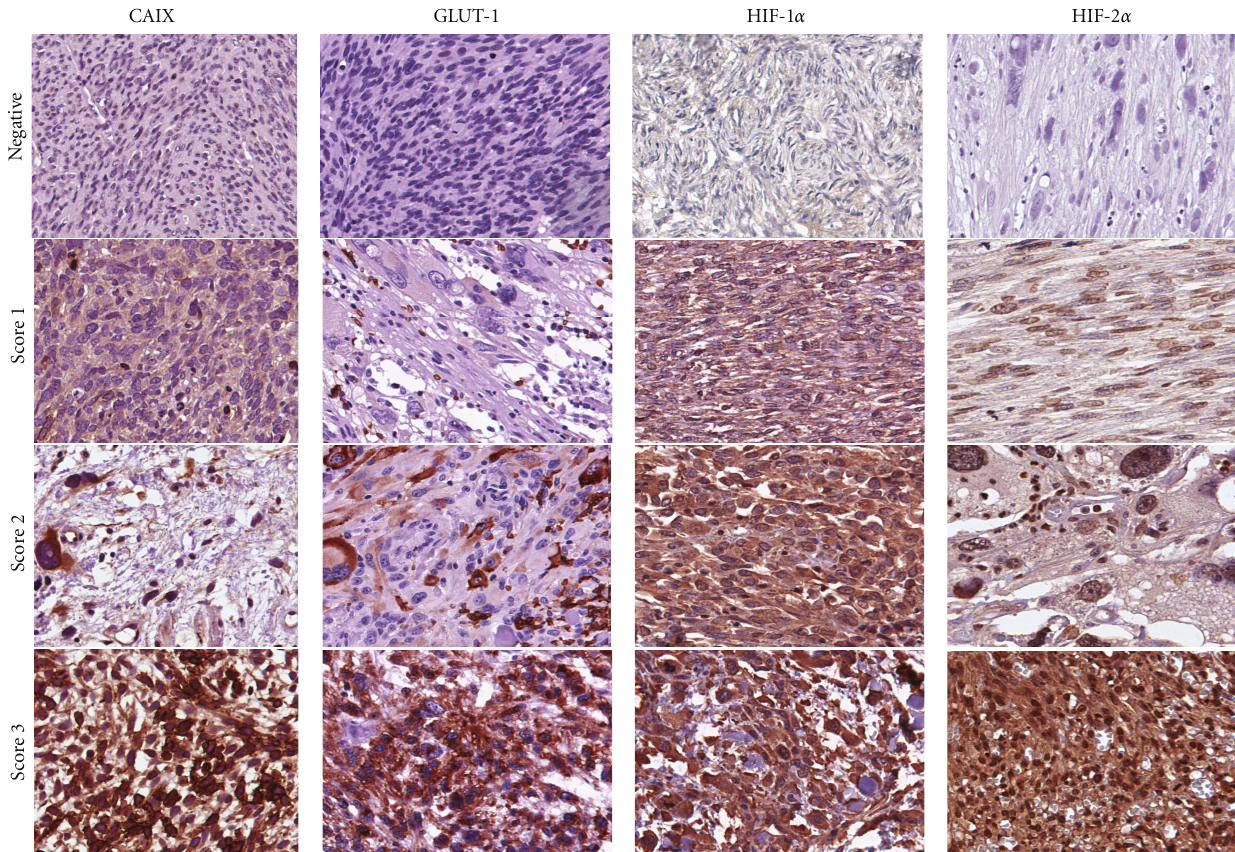
Figure 1: Immunohistochemical analysis in non-GIST STS representing negative, and score 1–3 of CAIX, GLUT-1, HIF-1 α , and HIF-2 α . non-GIST STS: non-gastrointestinal stromal tumor soft-tissue sarcomas, CAIX: carbonic anhydrase IX, GLUT-1: glucose transporter-1, and HIF-1/2 α : hypoxia induced factor 1/2 α